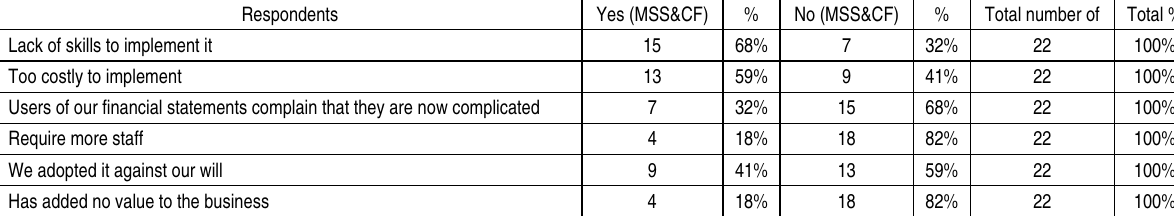
Table 3. Challenges of implementing IFRS for